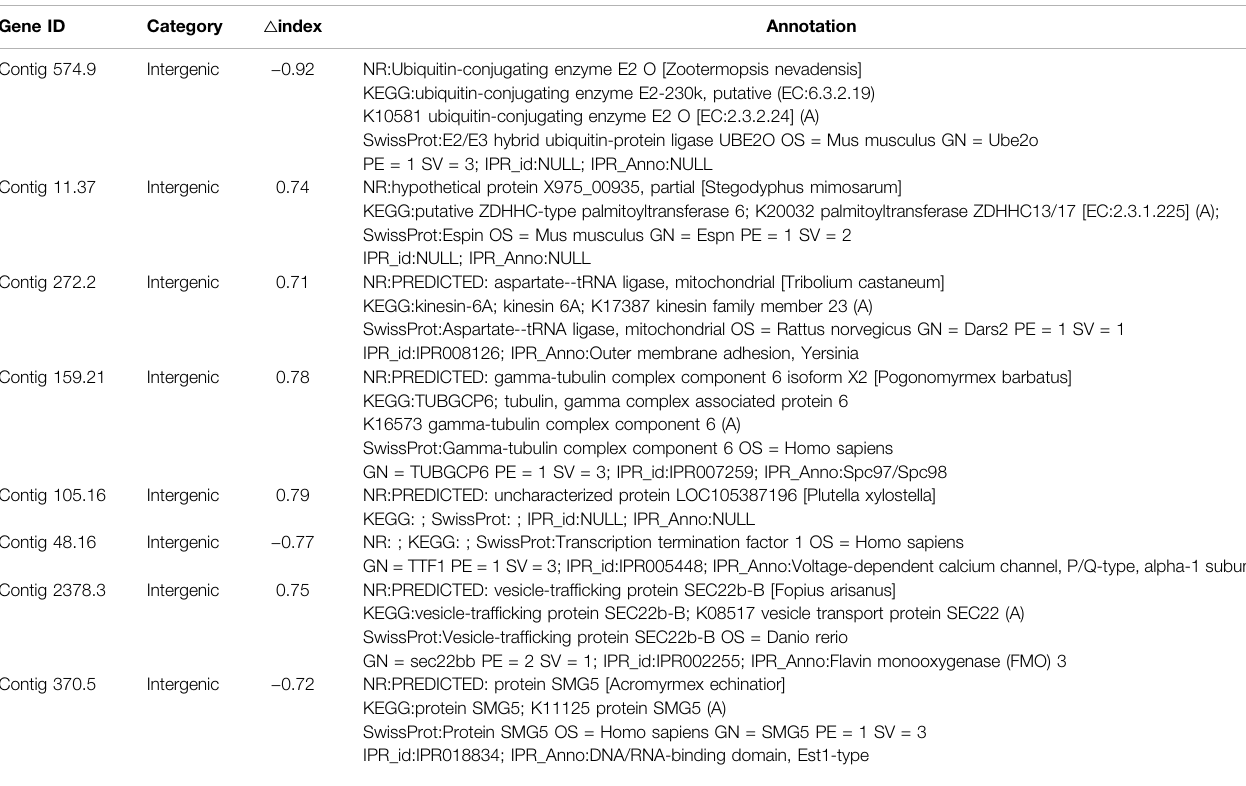
TABLE 5 | Annotation information of salt-alkali tolerance candidate genes.